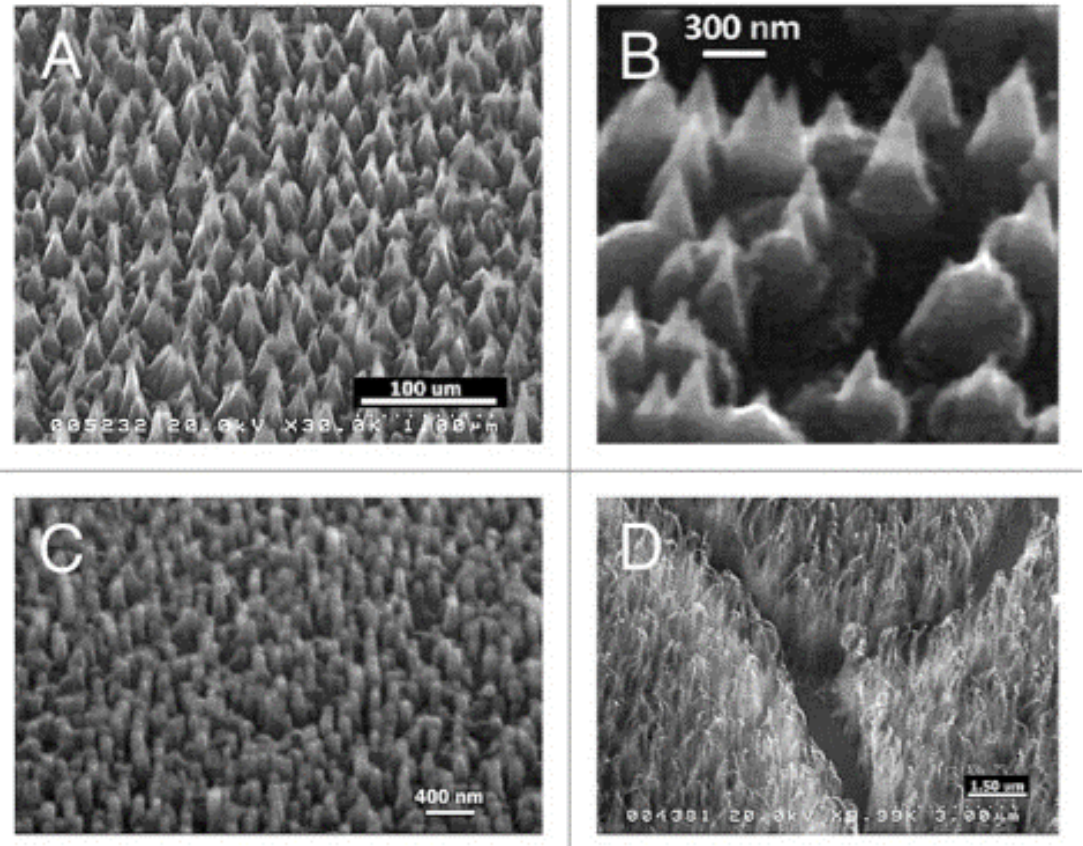
Figure 4. SEM images of diamond nanocones ( A , B ), nanopillars ( C ) and nanowhiskers ( D ), produced by the sculpturing of plane diamond films by means of a MW-RF CVD plasma reactor (From Ref. [102]).